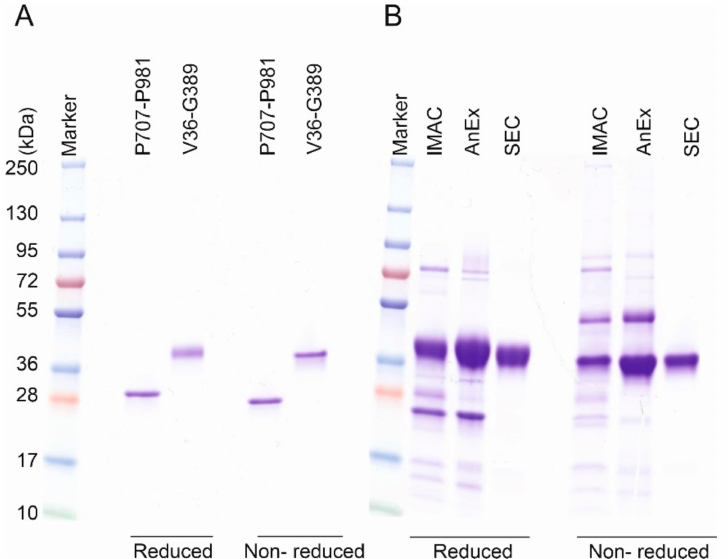
Figure 2. Representative coomassie stained SDS-PAGE gels. ( A ) Reduced and non-reduced samples of purified alpha tectorin (P707-P981) and mucin 2 construct (V36-G389). ( B ) SDS-PAGE gel of the mucin 2 construct after each purification step. An additional slower moving species can be seen in the non-reduced NEM treated samples after IMAC and anion exchange (AnEx), suggesting at least one additional redox state, which may involve a disulfide-linked hetero- or homo-dimeric state degradation